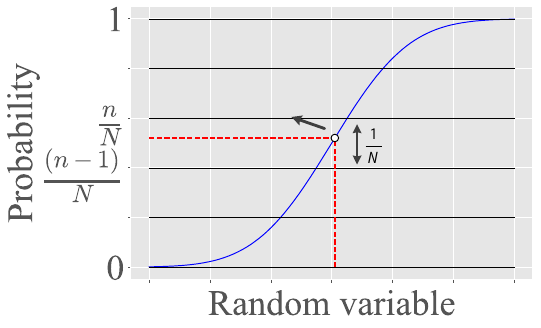
Figure 1. Sampling process of Latin hypercube sampling (LHS).